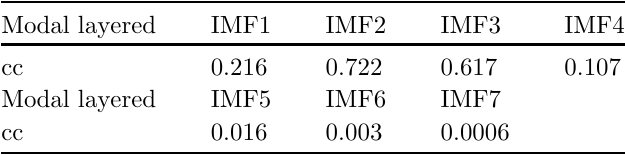
Fig. 7. Original test signal. Table 4. Correlation coef fi cient between intrinsic mode and original signal.